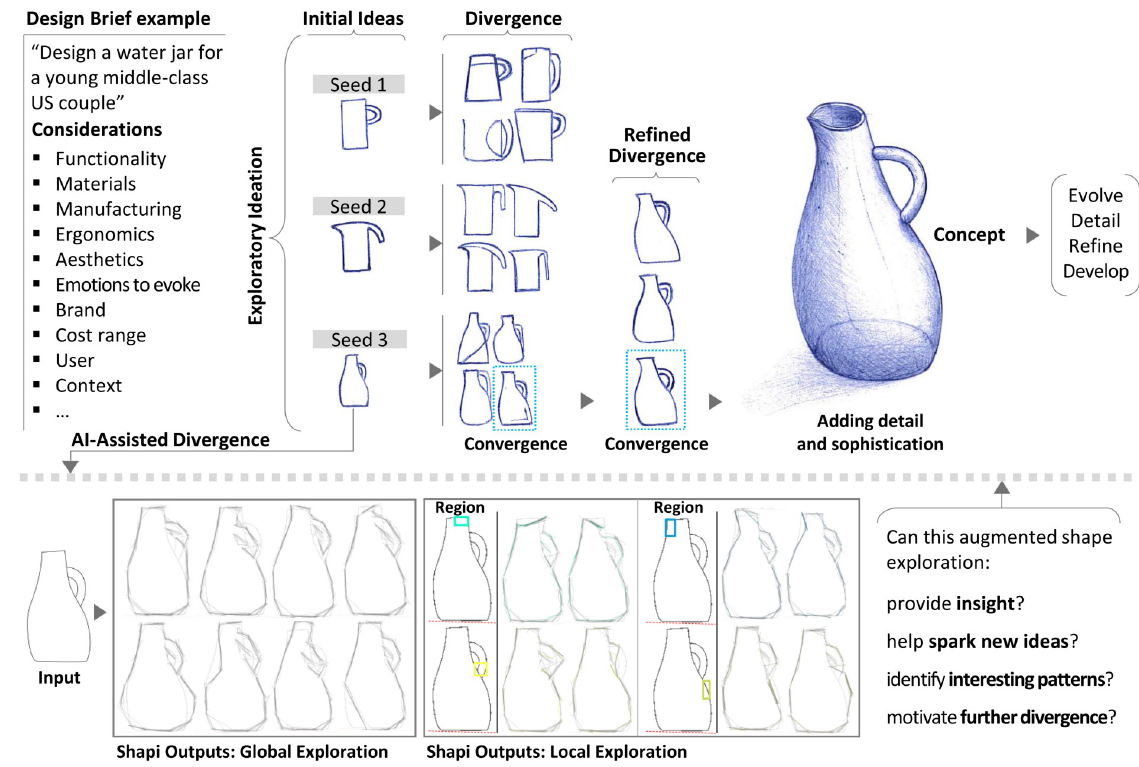
Fig 1. A simplified example of the divergence-convergence cycles of shape exploration for the conceptual design of a water jar. The basic shape can be progressively refined with rough sketches before developing the concept further. This work proposes an AI (Artificial Intelligence) tool, Shapi , for assisting shape exploration divergence as a process parallel to human sketching. Shapi generates variations around a given ‘Seed’, where Global variations can be used to catalyze insight or ideas about the overall shape or particular details anywhere in the contour, while Local variations can be used for more systematic inspections of the different shape